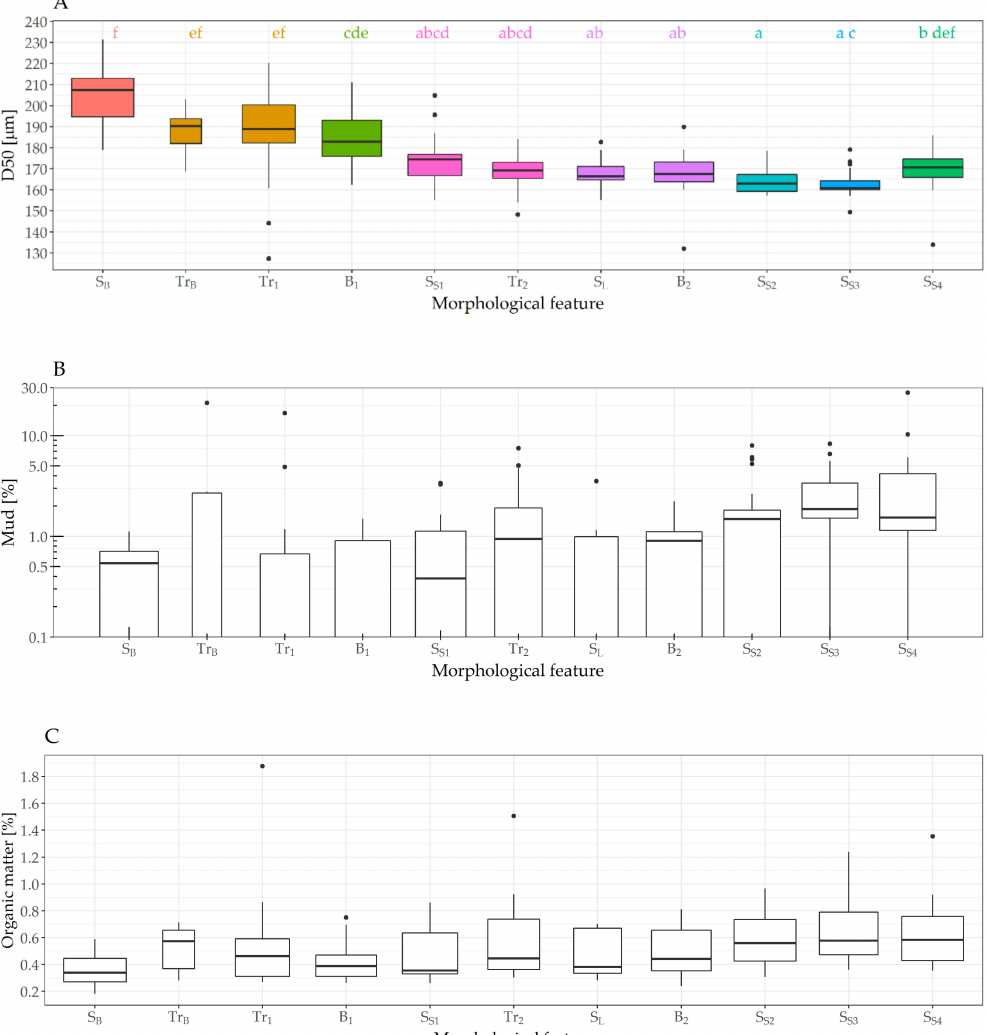
Figure 4. Boxplots of the sediment characteristics at the morphological features. ( A ) Median grain size D50. The letters at the top represent the groups resulting from the post-hoc comparison. Morphological featureswithequallettersshowmuchresemblance. Thelettercombinationsindicateifthemorphological feature is standalone or a gradient with elements from other morphological features. ( B ) Percentage of mud. ( C ) Organic matter. Note that the distance between the morphological features on the x -axis is not to